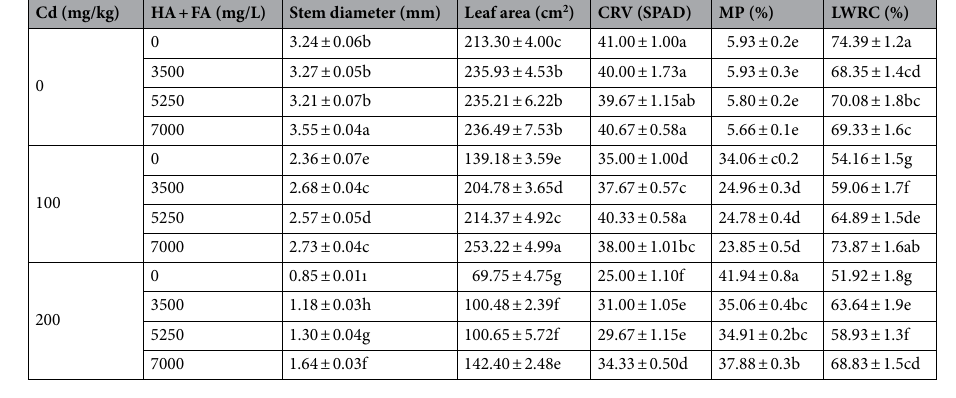
Table 2. Effect of cadmium and HA applications on stem diameter, leaf area, CRV, MP and LRWC of garden cress. The difference between the means indicated by different letters in the same column is statistically significant (Duncan multiple comparison test, P < 0.05).